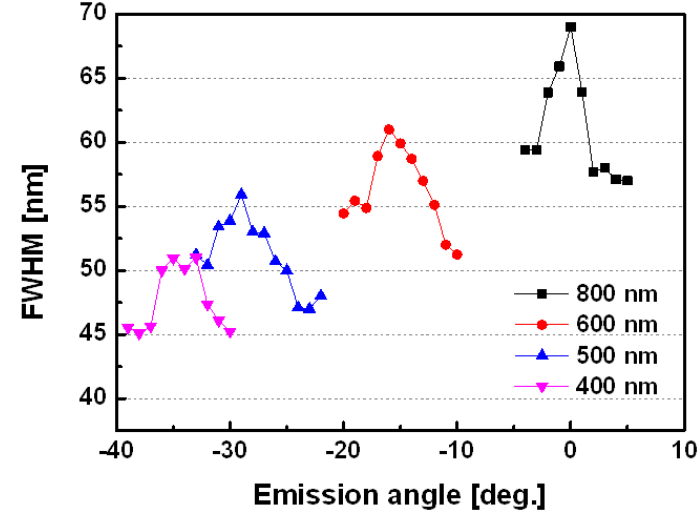
), and momentum shift ( Δ K) at different e